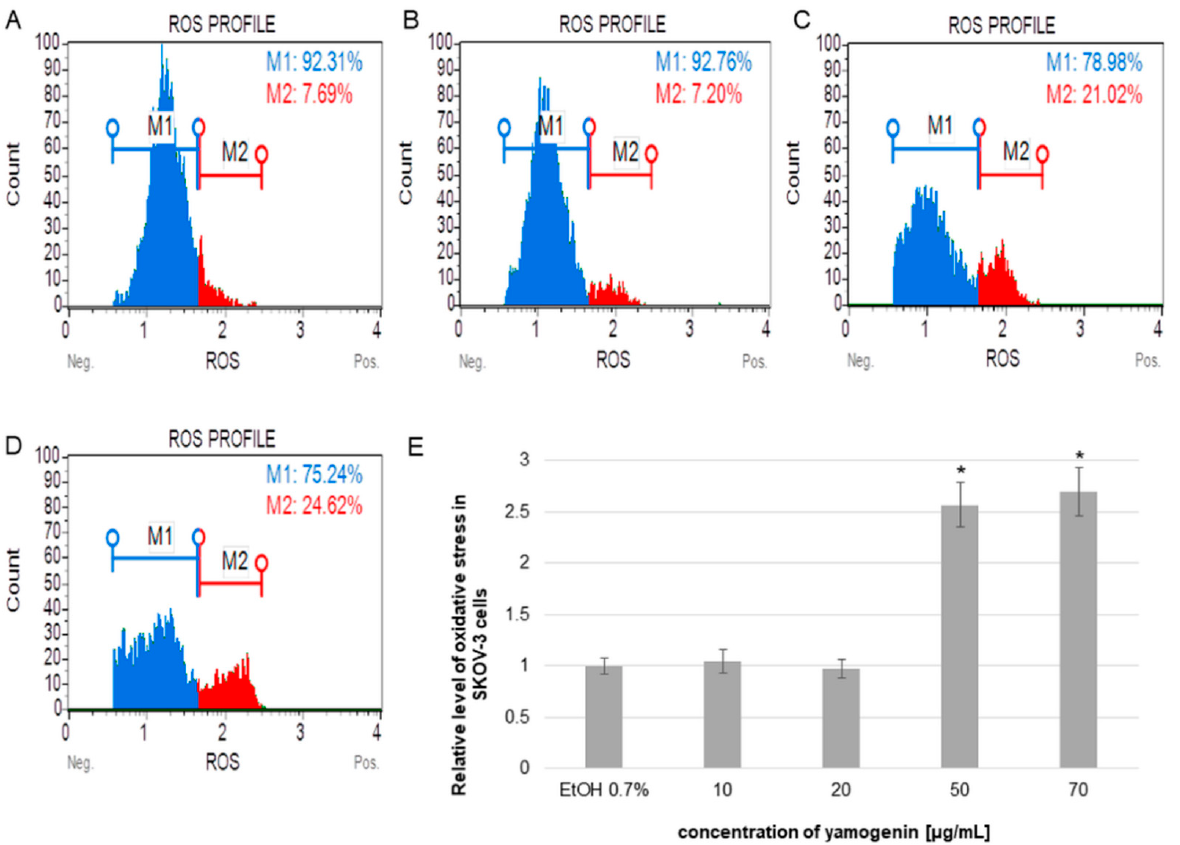
Figure 7. The relative level of oxidative stress production in SKOV-3 cells treated with yamogenin. The cells were incubated with ethanol (0.7%, ( v / v )—a control, ( A )), and yamogenin at concentrations of 10, 20 ( B ), 50 ( C ), and 70 µ g/mL ( D ). The results were obtained with flow cytometry and are presented as the means ± SD of three independent experiments ( E ). Error bars represent standard deviations. Significant differences relative to the control are marked with an asterisk (the Student’s t -test, * p < 0.05).